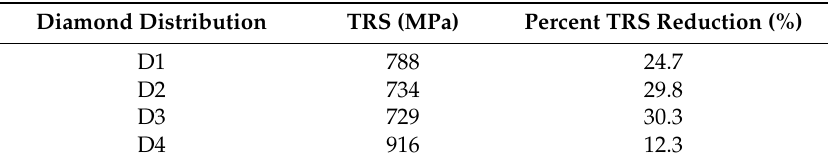
Table 7. Percent TRS reduction for different diamond distributions.